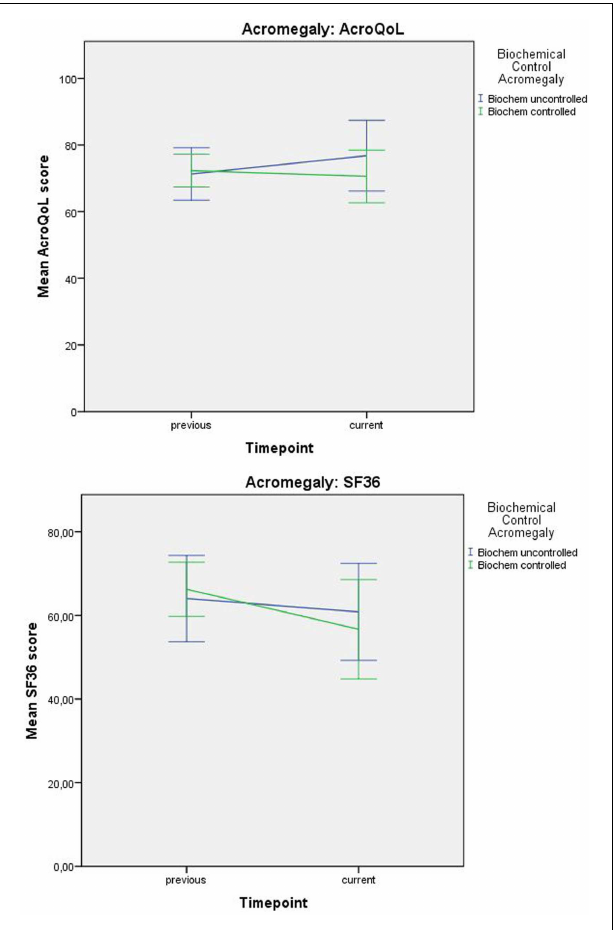
FIGURE 3 | Progression of QoL (mean values) in acromegaly relative to biochemical status . Error bars represent 95%